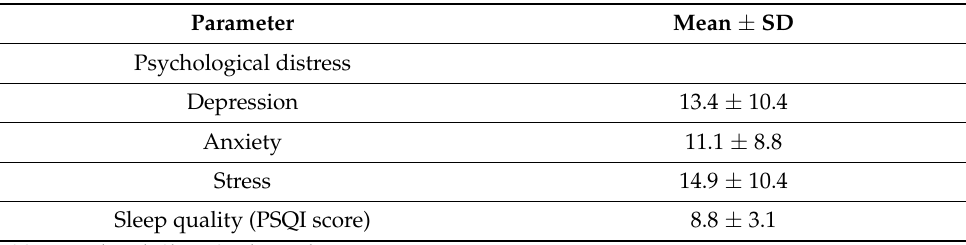
Table 2. Psychological distress and sleep quality scores.